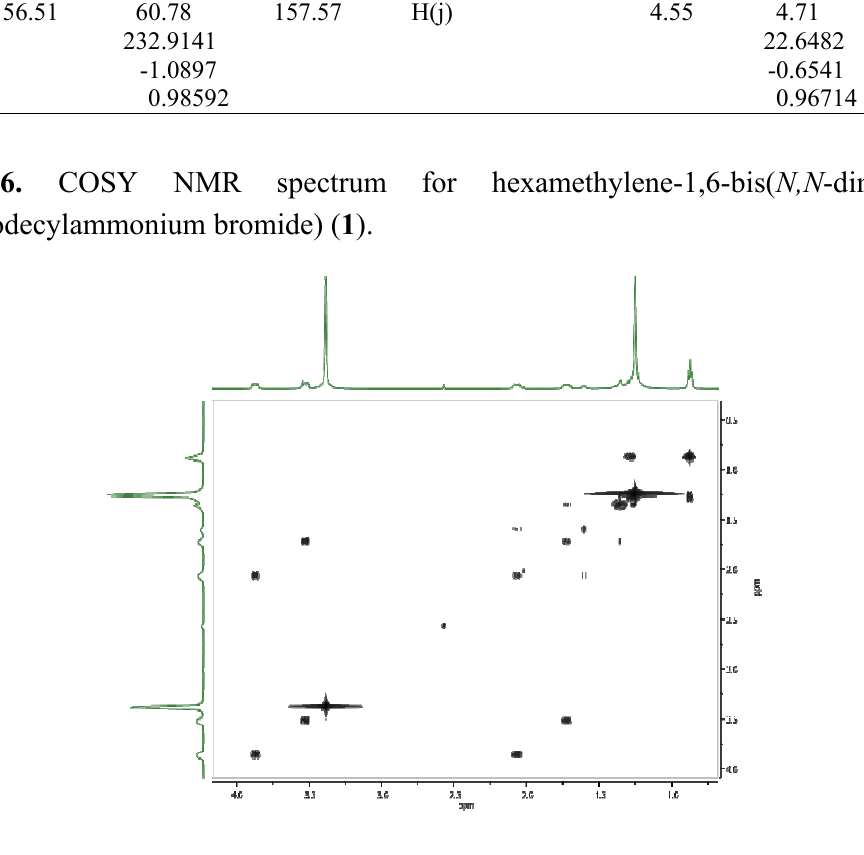
, CD Cl) in hexamethylene-1,6-bis( N,N - exp 3 calc) = a + b· σ : (a) 13 C and (b) 1 H. exp calc